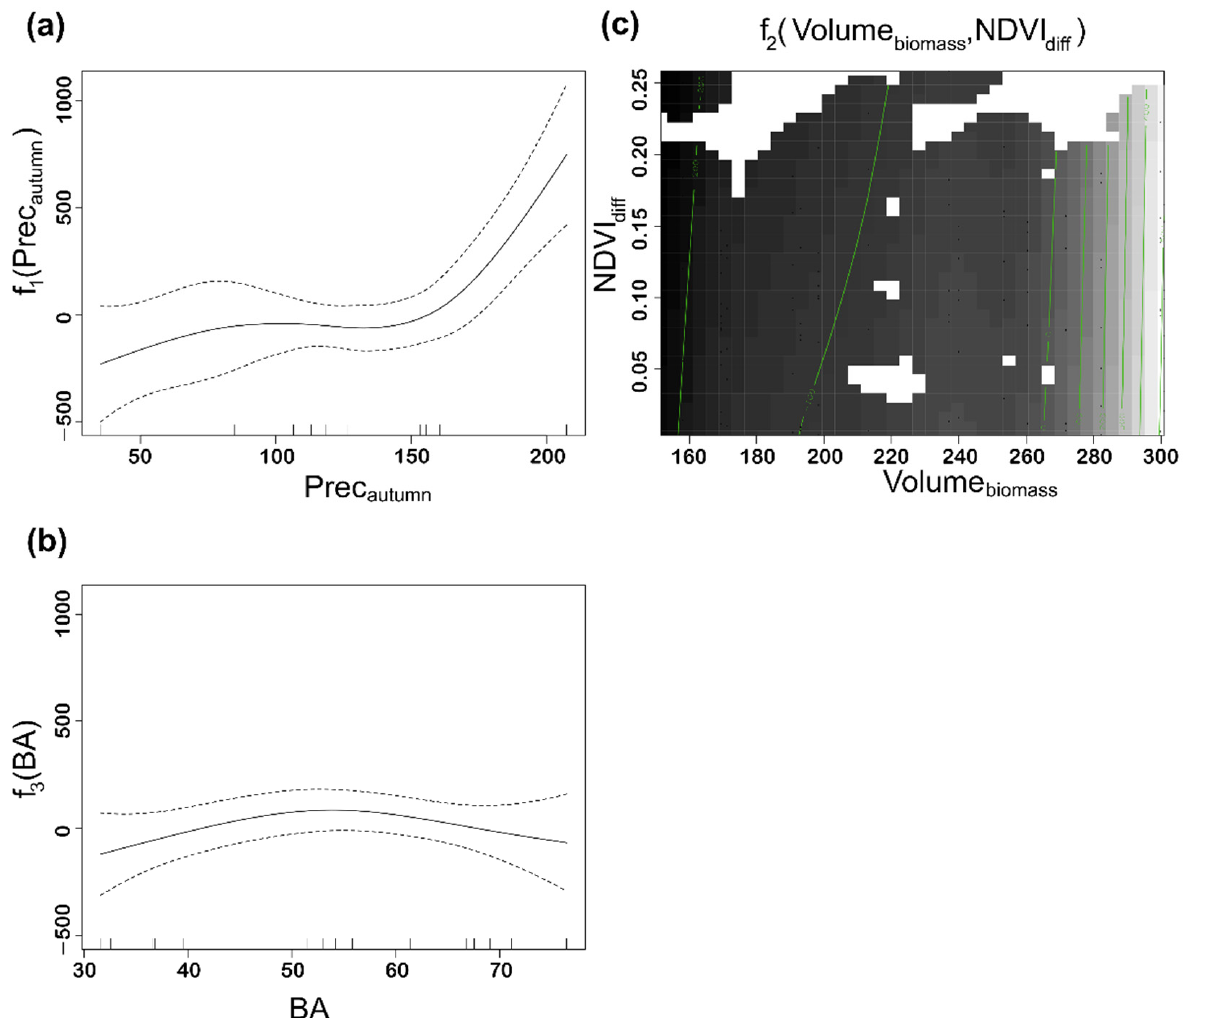
Figure 8. Non-linear effects of the variables for the model developed for Lactarius deliciosus (Equation (3)). ( a ) Prec autumn ; ( b ) BA; and ( c ) interaction between Volume biomass and NDVI diff . In the two-dimensional graph ( c ), white shows a positive effect and black a negative effect; green contour lines show where the function has a constant value.